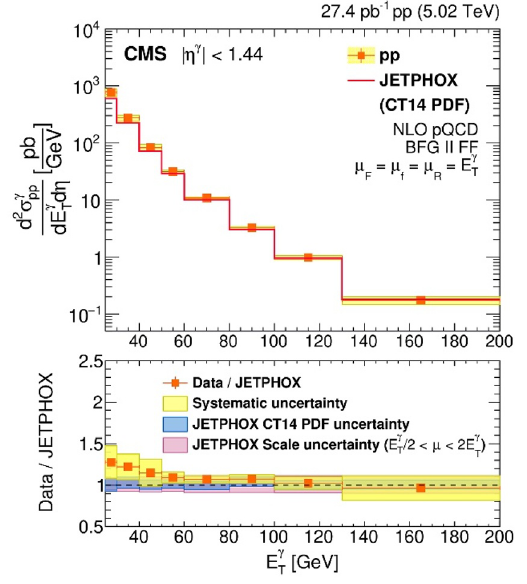
Figure 4 . Isolated photon cross section (upper) measured as a function of E g in pp collisions T at 5.02 TeV. The symbols are placed at the center of the bin. The vertical bars associated with symbols indicate the statistical uncertainties and the horizontal bars re(cid:13)ect the bin width. The statistical uncertainties are smaller than the symbols. The total systematic uncertainties are shown as boxes in each E g bin. The data are compared to the NLO jetphox calculations with CT14 T PDFs. The ratio of the data to jetphox is shown in the lower panel. The yellow boxes indicate the total systematic uncertainties of the data. The blue and red hatched boxes correspond to jetphox PDF and scale uncertainties,